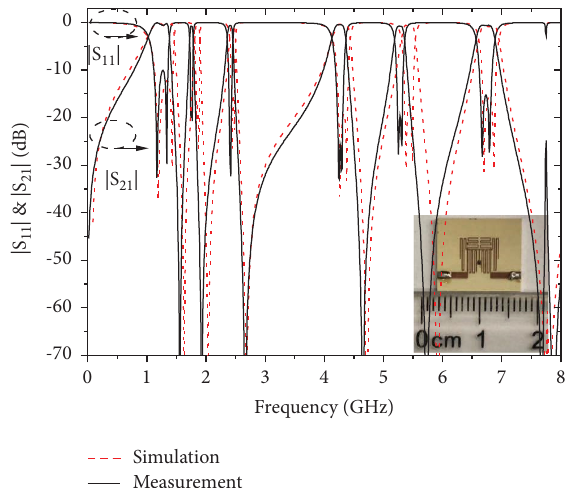
Figure 15: Simulated and measured results of sext-band